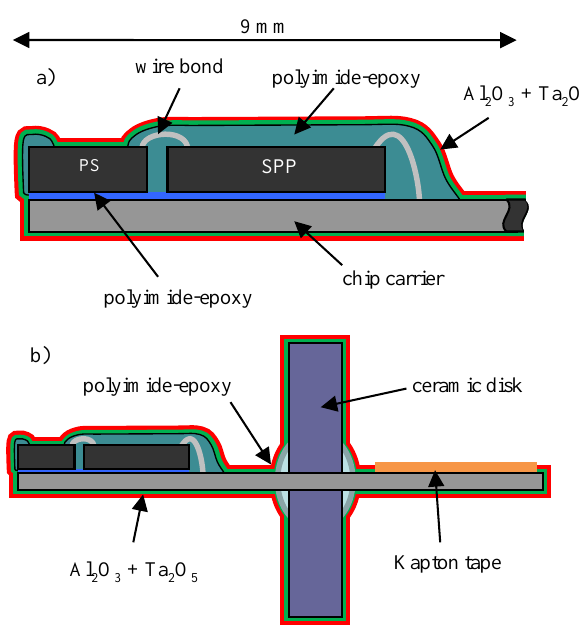
Figure 2. (a) Sketch of the pressure sensor module and encapsu- lation concept in cross-section. (b) Schematic representation of the entire sensor assembly with ceramic disc separator and taped pad structures.